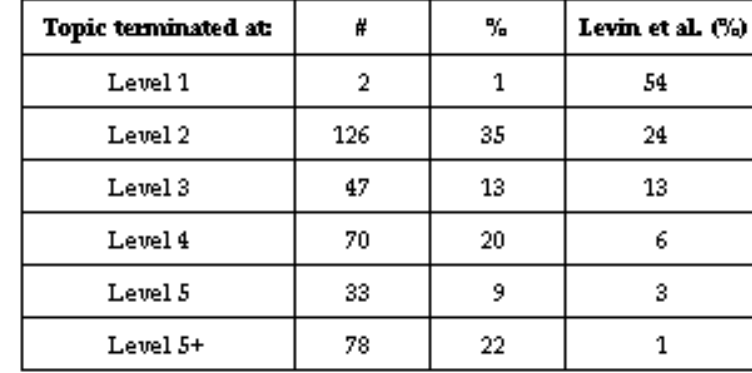
Table 2: Persistence in student topic